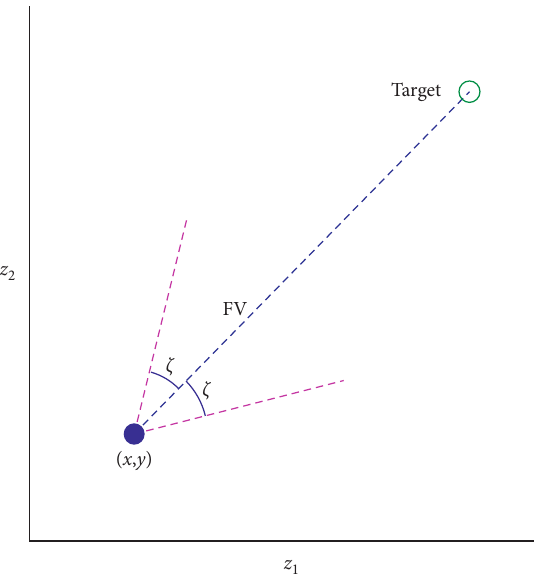
Figure 3: Landmark navigation of the 2D point robot with initial position ( 5 , 5 ) and the target placed at ( 25 , 25 ) .